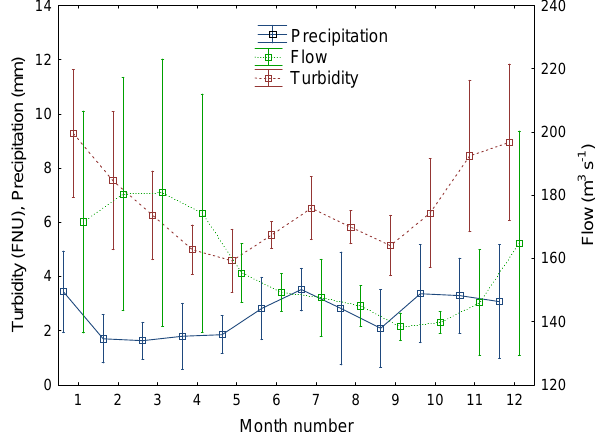
Fig. 7. Monthly mean for precipitation at station G¨oteborgA, flow in the river G¨ota ¨Alv, the southern branch, and turbidity at station L ¨ arjeholm (2002–2007).